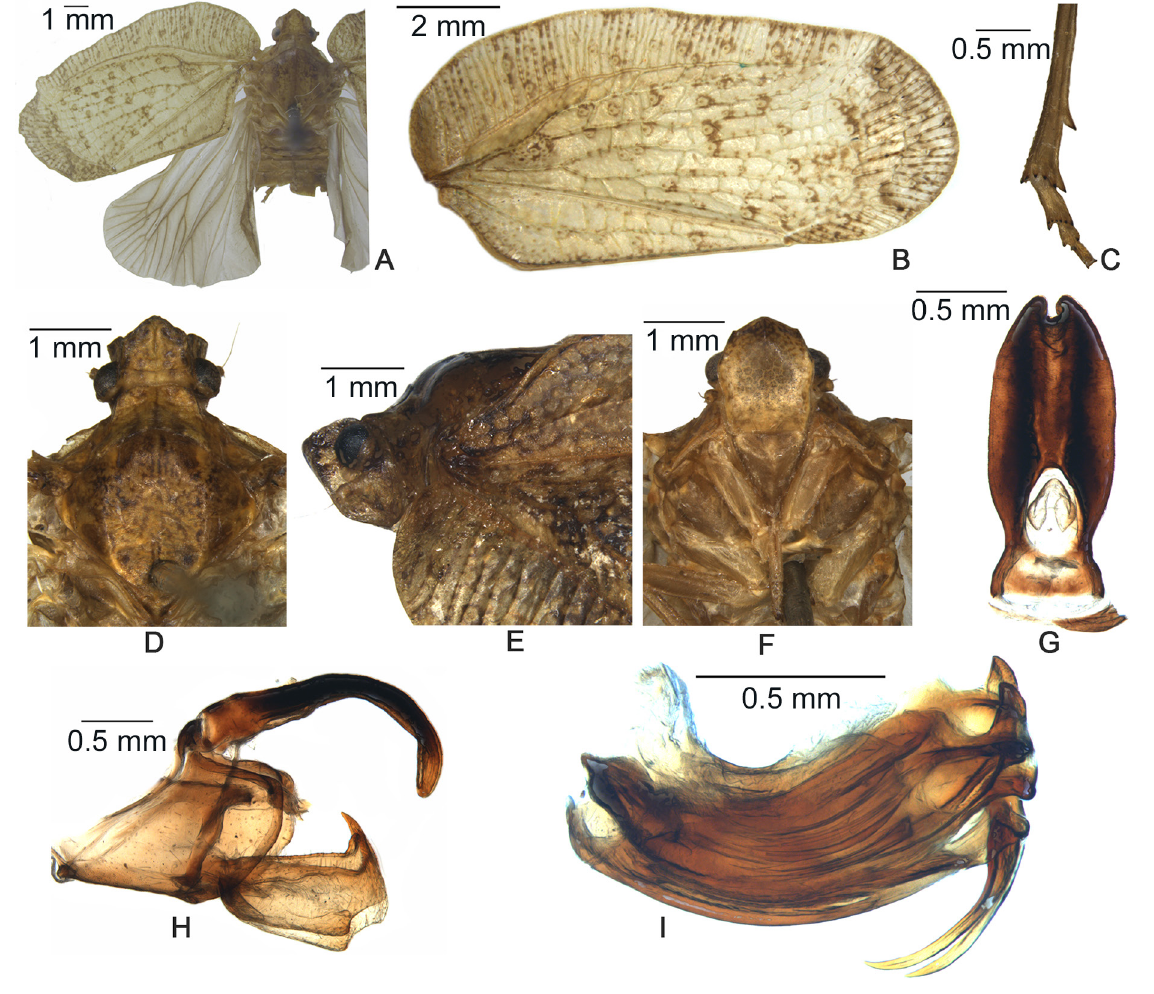
Fig. 8. Atracis sphaerica sp. nov. A . Habitus, dorsal view. B . Tegmen. C . Hind leg apex. D . Head and thorax, dorsal view. E . Head and thorax, left lateral view. F . Face. G . Male anal tube, dorsal view. H . Male genitalia (phallic complex removed), right lateral view. I . Phallic complex, right lateral